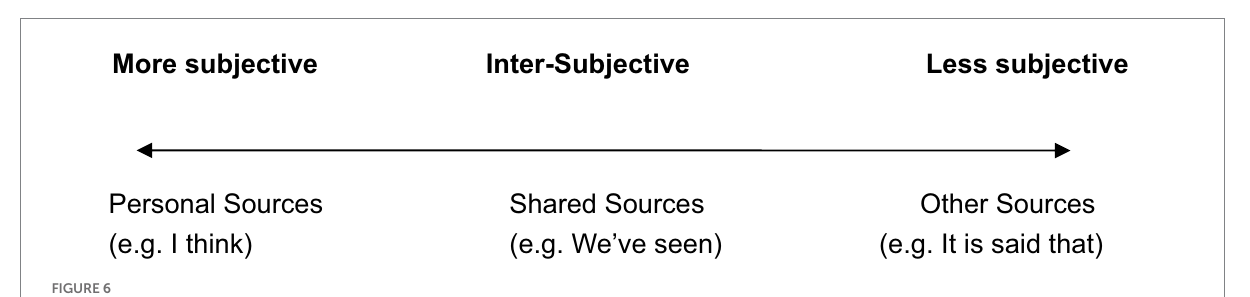
FIGURE 6 The scale of (inter)subjectivity vs. the source of